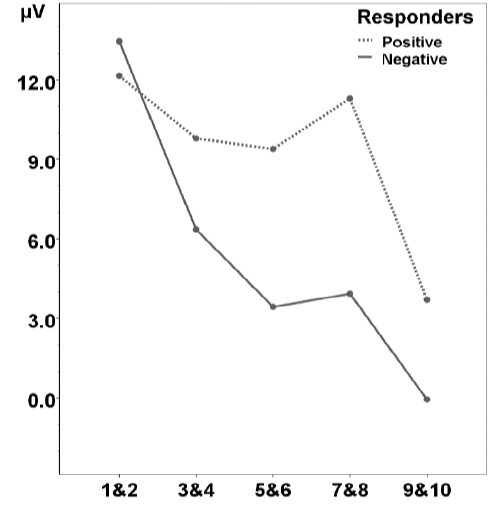
Figure 2. Mean amplitude in μV per word pair in the familiarization phase of isolated words from 200 to 500 ms from word onset, separate for the subgroups of infants who show a Positive or Negative word familiarity effect at test (Positive and Negative Responders,